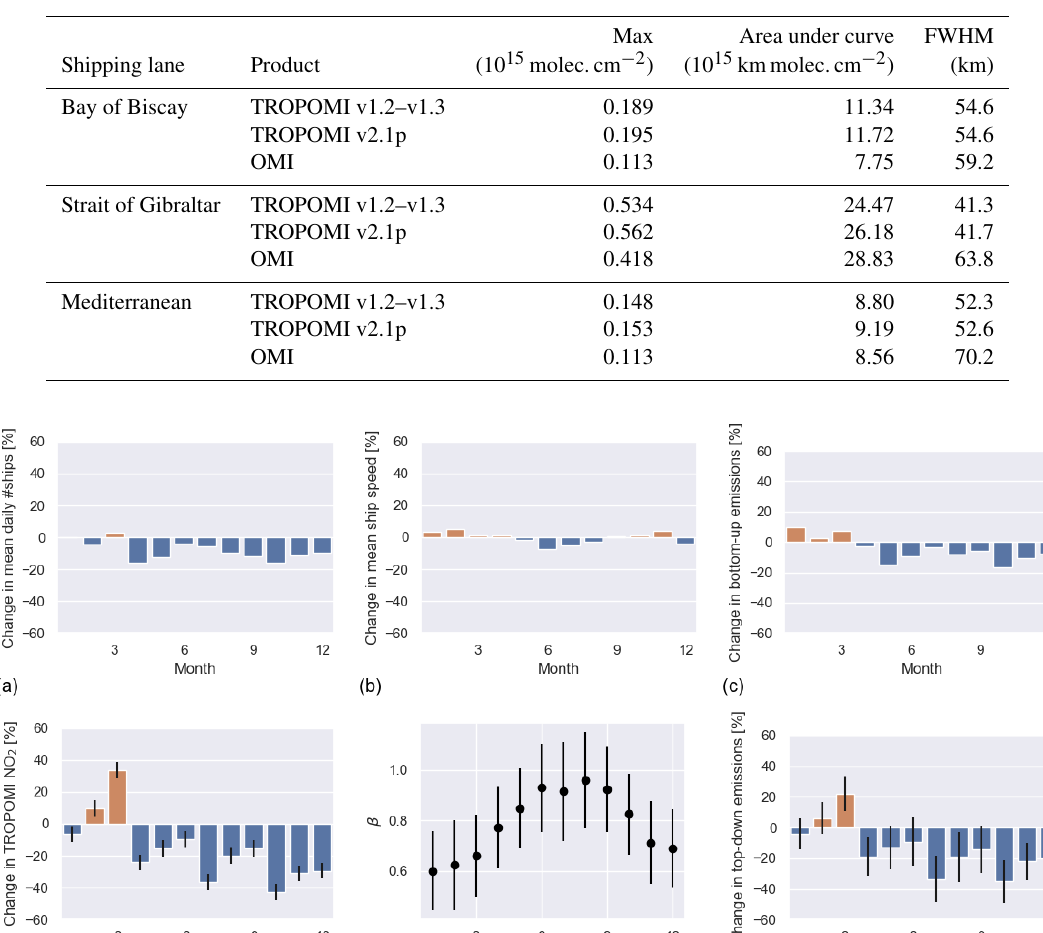
Table 4. Statistics for the NO 2 enhancement cross section over the Mediterranean shipping lane.